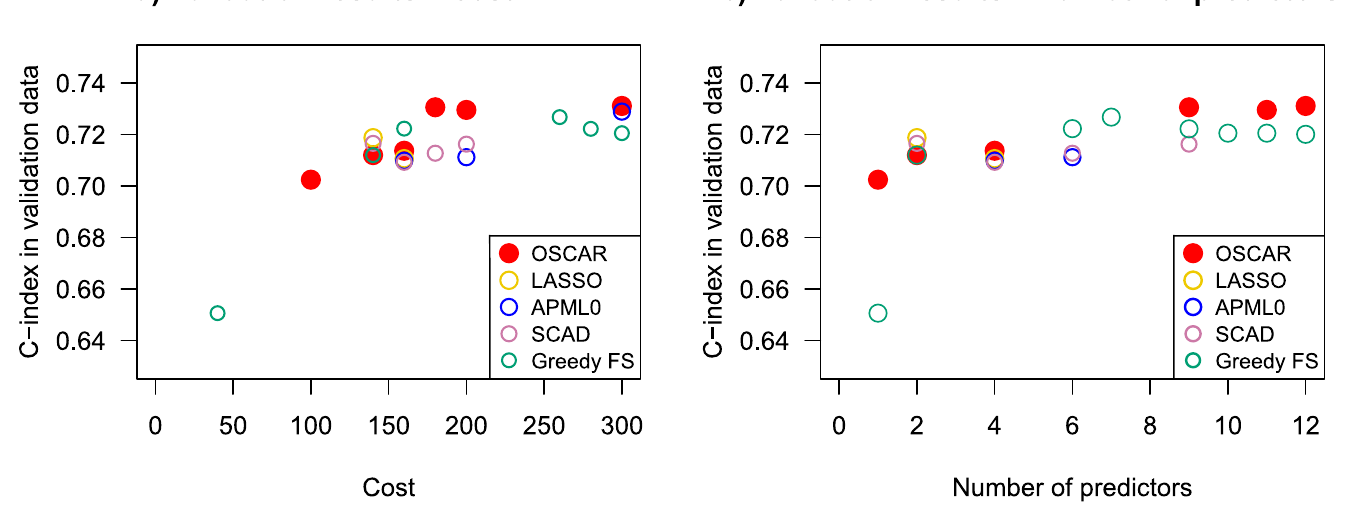
Fig 4. Model accuracy in the validation data cohort for OSCAR (red filled circles), LASSO (yellow hollow circles), APM- L 0 (blue hollow circles), SCAD (light purple hollow circles), and Greedy FS (green hollow circles). a) with respect to the corresponding costs, b) with respect to the corresponding number of predictors. Only the performance of the models in the corresponding approximated Pareto-fronts are